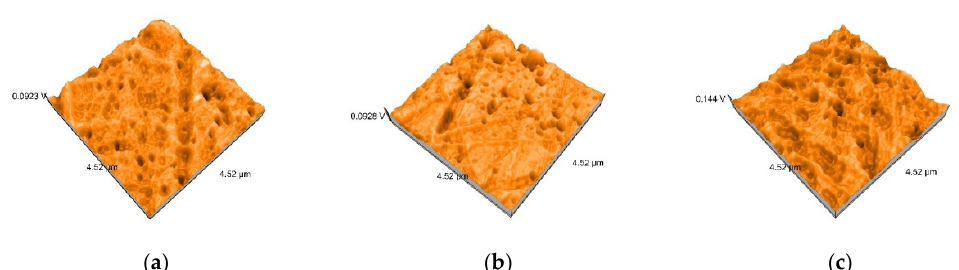
Figure 12. 3D AFM images of the thermoformed S samples after mechanically brushing: ( a ) SCX (Sa = 7.5 nm, Sp = 52 nm, Sv = − 43 nm); ( b ) SKX (Sa = 8.7 nm, Sp = 59 nm, Sv = − 51 nm); ( c ) SWX (Sa = 22 nm, Sp = 85 nm, Sv = − 66 nm); ( d ) STX (Sa = 43 nm, Sp = 89 nm, Sv = − 98 nm).